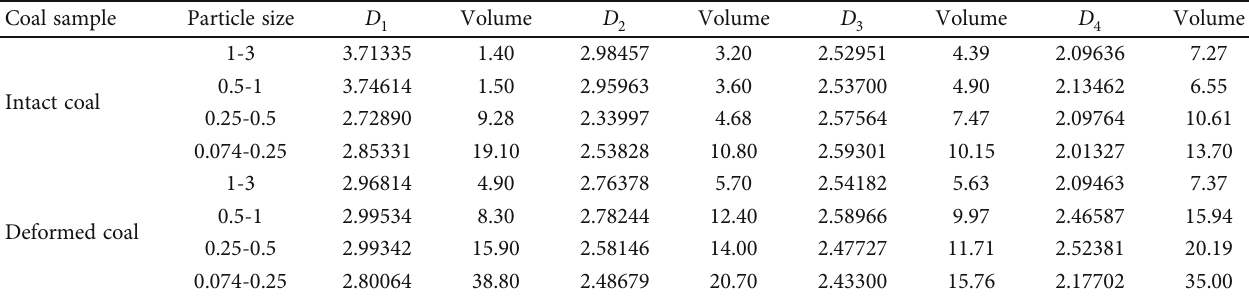
Table 5: Relationship between pore volume parameters and fractal dimensions.